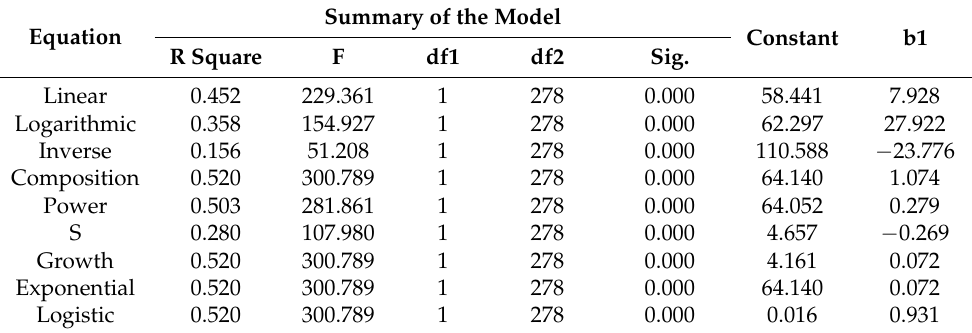
Table 2. Testing linear and non-linear functions for the variables telework (T.W.) and economic performance (GDPC).